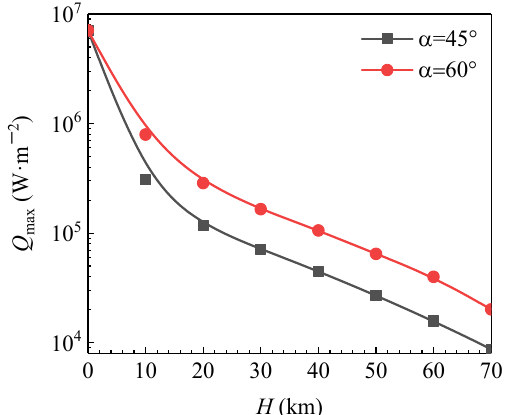
Figure 12. Maximum heat flux of surface with altitudes in two launching angles.